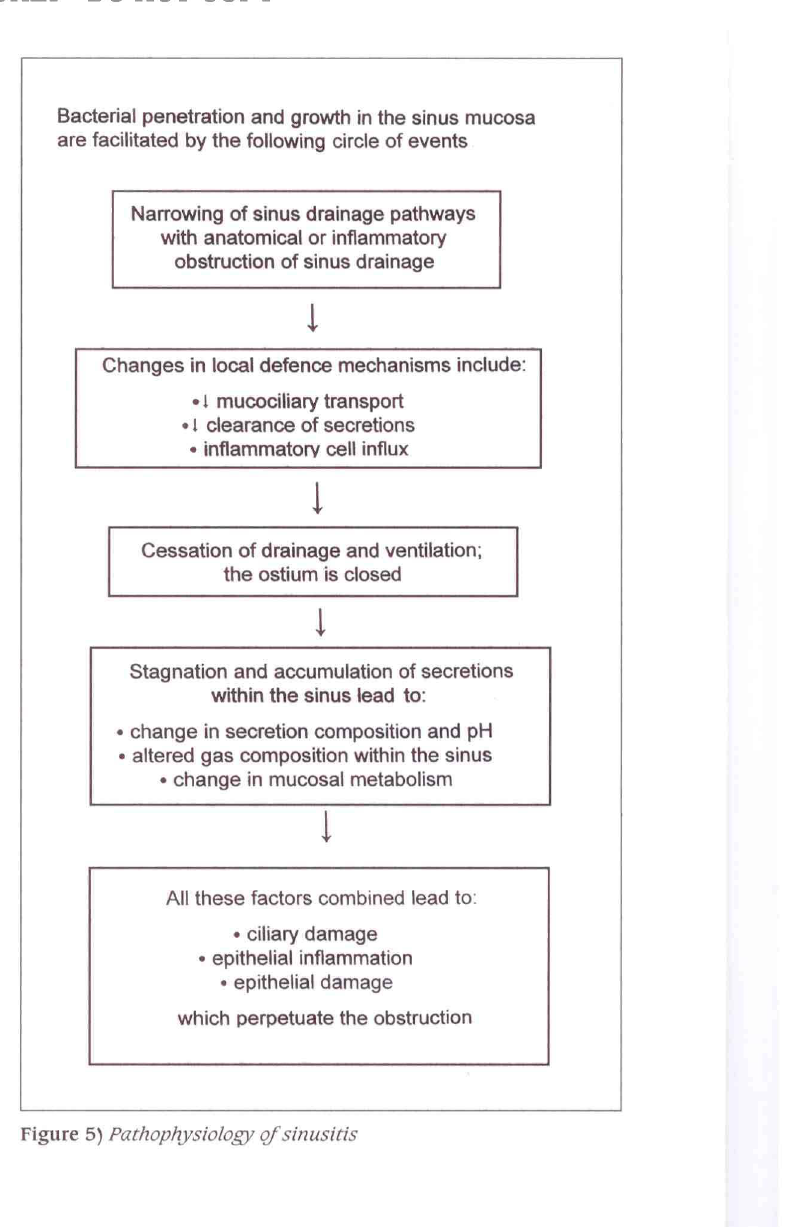
Figure 5) Pathophysiology ef sinusitis